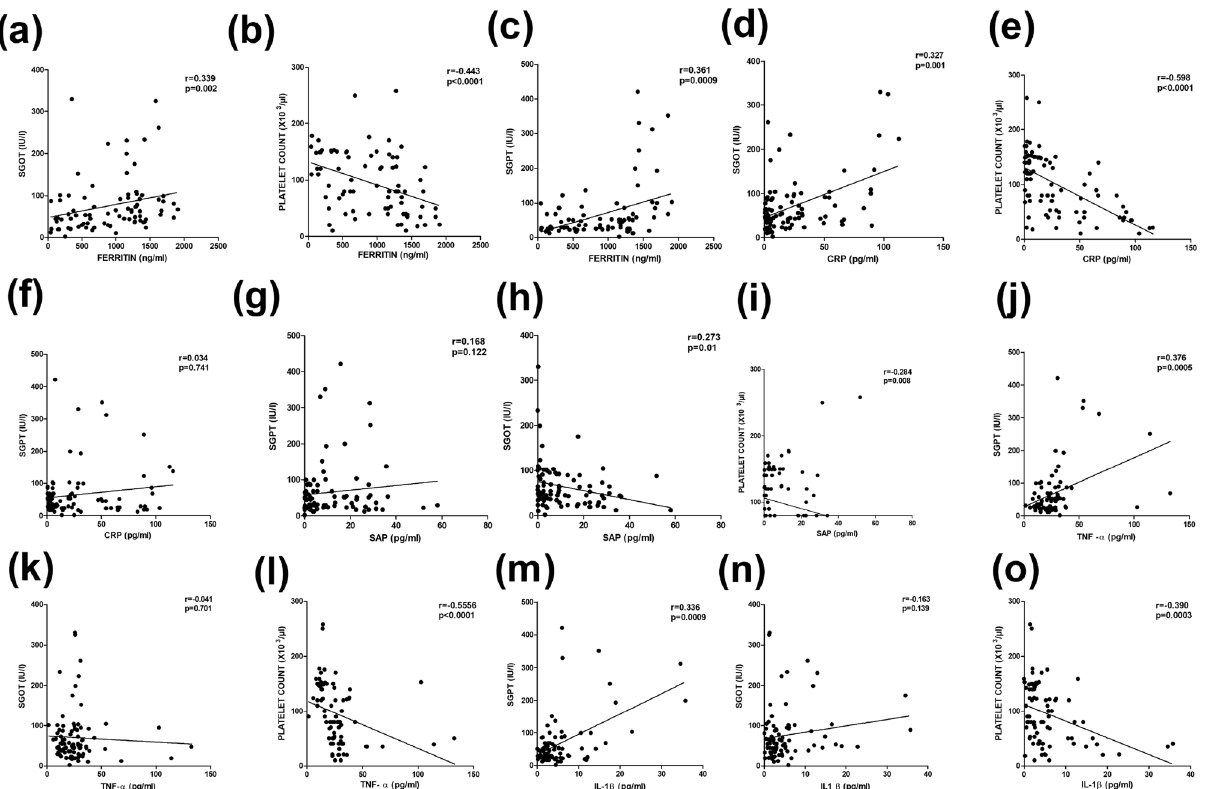
Figure 7. Correlation of ( a ) SGOT versus Ferritin, ( b ) Platelet versus Ferritin, ( c ) SGPT versus Ferritin, ( d ) SGOT versus CRP, ( e ) Platelet versus CRP, ( f ) SGPT versus CRP, ( g ) SGPT versus SAP, ( h ) SGOT versus SAP, ( i ) Platelet versus SAP ( j ) SGPT versus TNF-α, ( k ) SGOT versus TNF-α, ( l ) Platelet versus TNF-α, ( m ) SGPT versus IL-1β, ( n ) SGPT versus IL-1β and ( o ) Platelet versus IL-1β in patients with dengue infection. Statistical analysis was performed using the Graph-Pad Prism statistics software (Graph-Pad Software Inc., San Diego, CA, USA free demo version